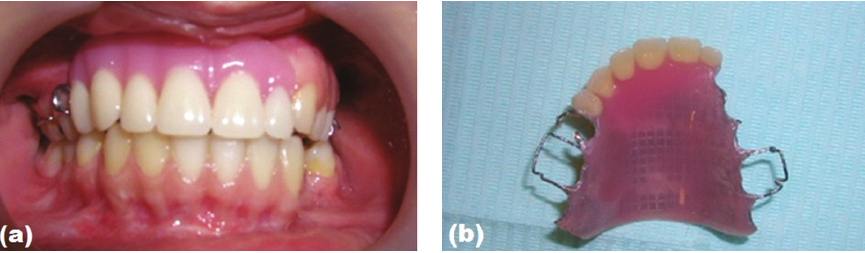
Figure 4: Intraoral view of temporary prosthesis with patient.